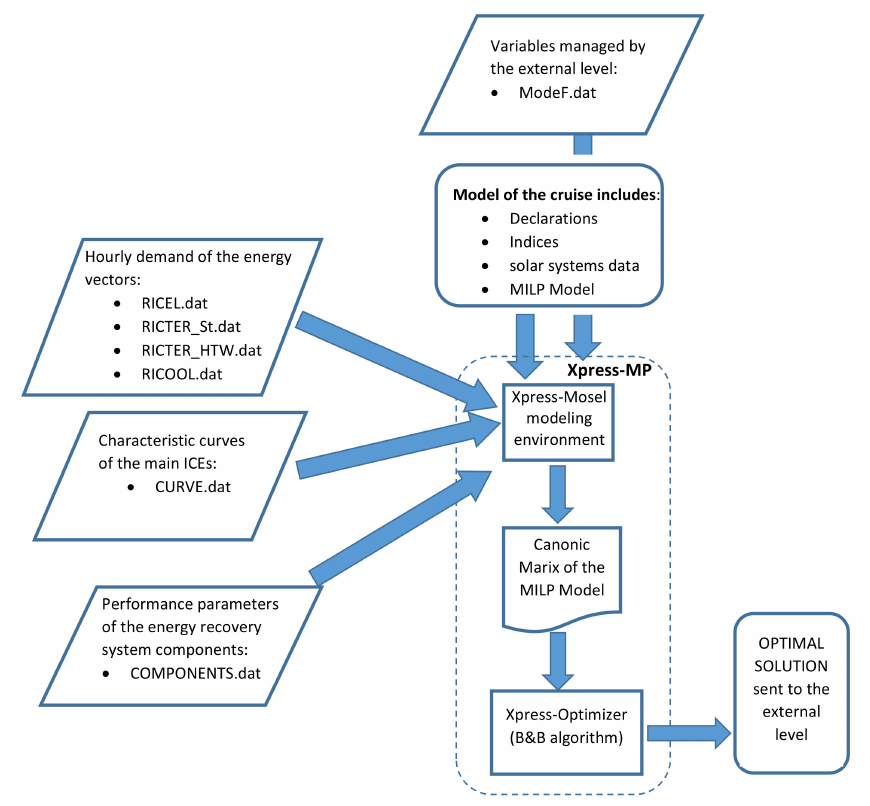
Figure 9. Scheme of the mixed-integer linear programming model of the system (MILP) procedure at the internal